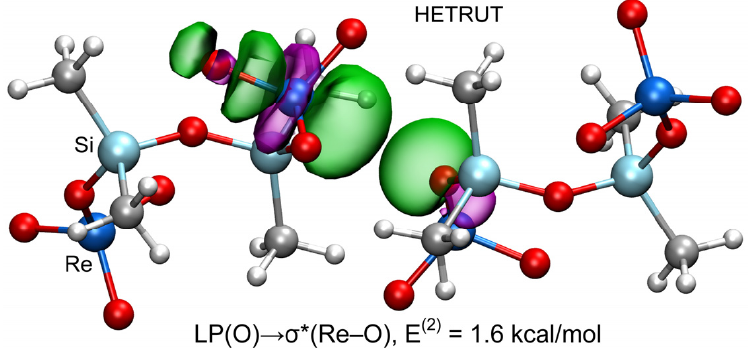
Figure 6. Representation of the filled and empty NBOs corresponding to the LP(O) → σ *(Re–O) do- nor–acceptor interaction in the MaB dimer HETRUT. The isosurface used for the MOs is 0.008 a.u.